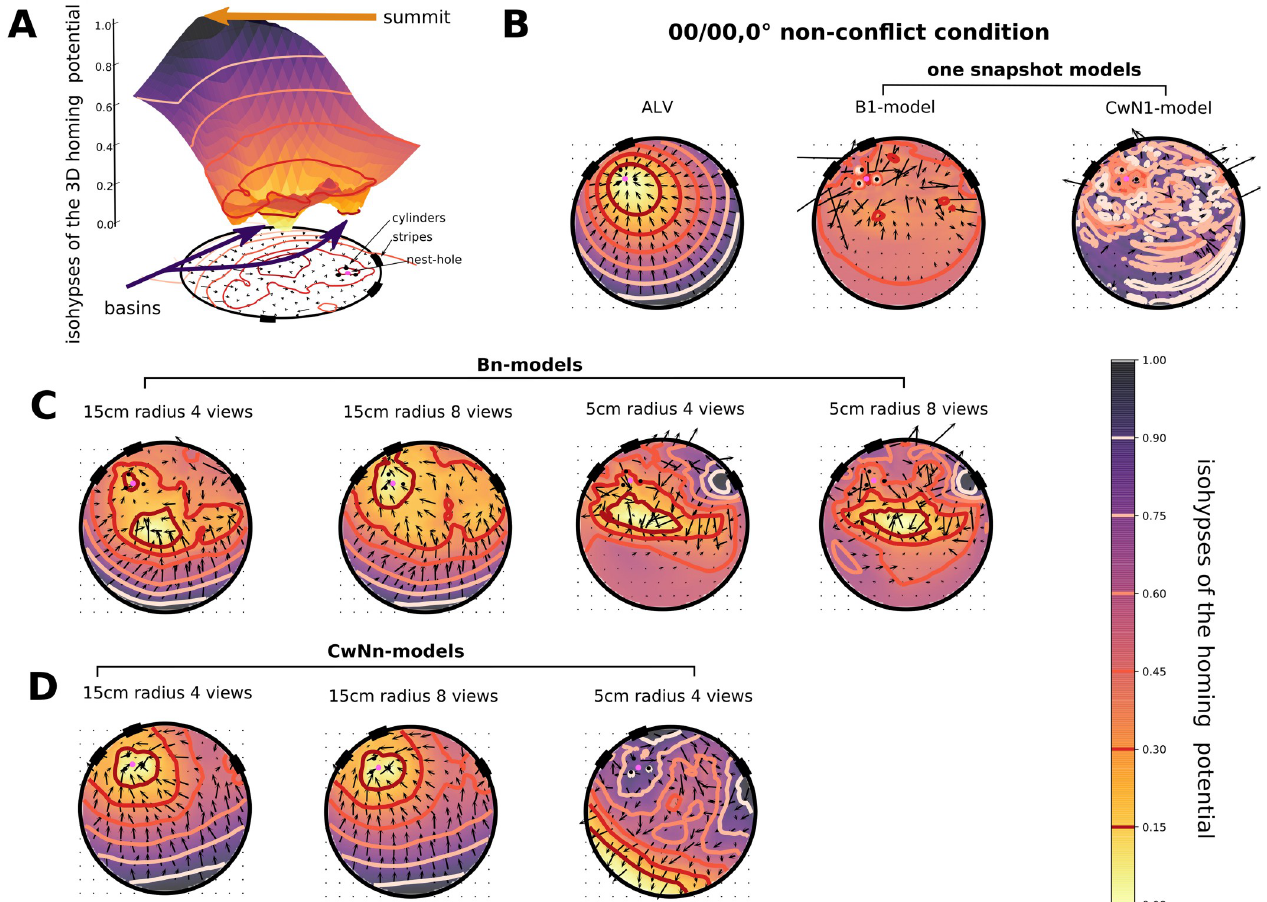
Fig 5. Model homing potential during non-conflict situation (condition 00/00,0). A: Helmholtz-Hodge Decomposition 3D profile of the B4-model, coloured along the z-axis, from yellow, basins, to black, summits, overlaid with contour lines indicating the different isohypses of the profile. Levels are projected on the ground with the schematic of the arena at the 00/00 condition. The nest hole is represented by a pink circle. In addition, the vector field from which the homing potential is derived is plotted. B: Performance of the ALV model homing and one-snapshot models (the type of model used is indicated above the individual plots), are described by the colourmap and the isohypses, overlaid with a vector field showing the homing vectors on each grid points of the downsampled grid. The performance of each model is plotted in the same manner. The yellow of the colourmap and the dark red of the contour indicates areas where the vector field is converging. C: Bn-models using 4 or 8 views taken at 15 cm or 5 cm from the nest (indicated above the plots). D: CwNn-models, based on 4 and 8 views taken at 15 cm from the nest, then 4 views taken at 5 cm from the nest.